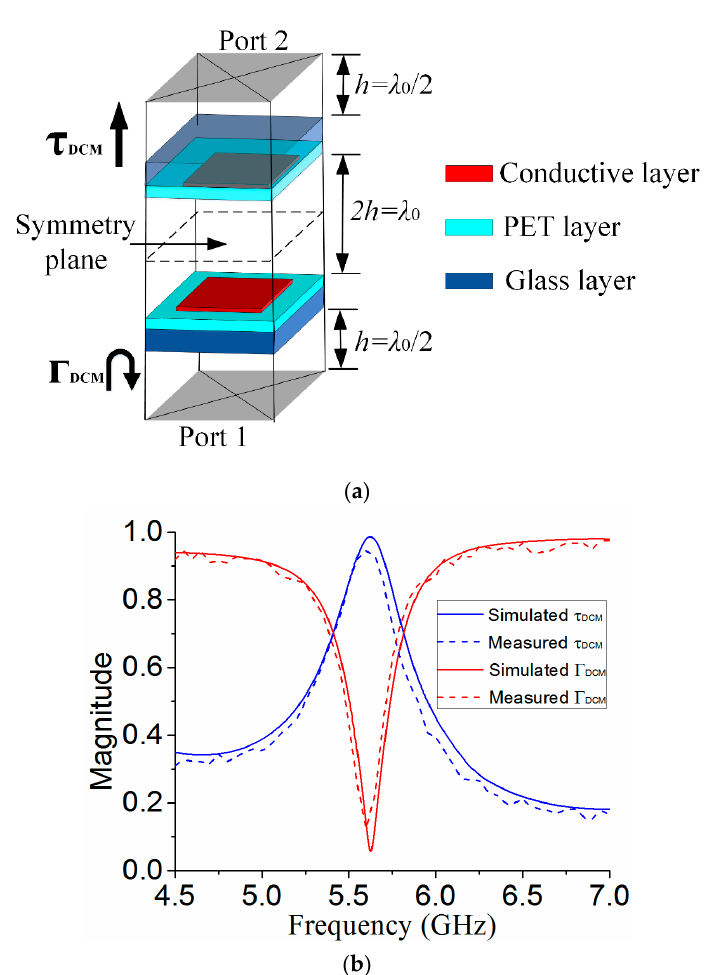
Figure 6. ( a ) Unit cell of the resonant cavity using DCM ( b ) simulated and measured reflection and transmission magnitude. transmission